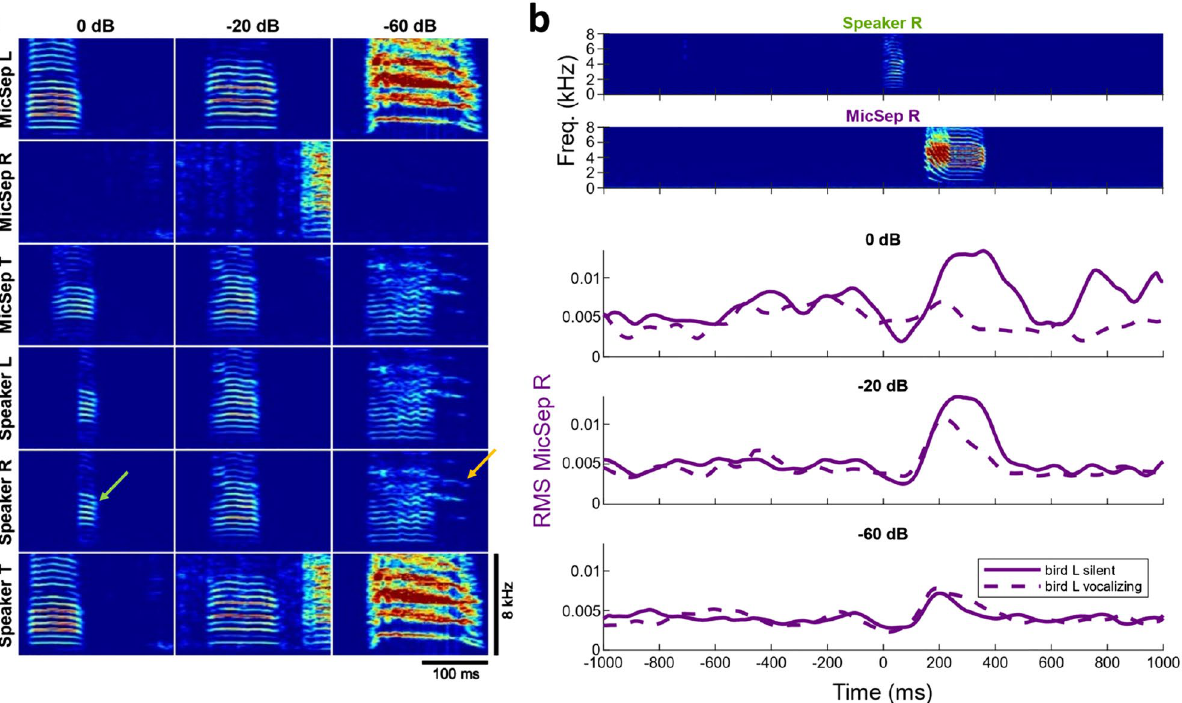
Figure 5. The leakage factor of the dynamic squelch sets the tradeoff between transmitting all local signals (i.e., soft calls) and suppressing leaked signals (i.e., loud residual echoes). ( a ) In a hierarchical network among 3 males, we set three different leakage factors, 0 dB (left), − 20 dB (middle), and − 60 dB (right). Shown are example spectrograms in which the top bird T produces a soft call (MicSep T) simultaneously with a loud call in L (MicSep L). A high dynamic squelch (left) produces a chopped version of T’s call on the Speaker R signal (green arrow). A midrange setting of the leakage factor (middle) preserves T’s call on Speaker R. Absence of dynamic squelching (right) produces a superposition of both calls on Speaker R, which entails that bird R can hear residual echoes of bird L (orange arrow). ( b ) Top: example spectrograms of a soft call in T (speaker R) and the response in R (MicSep R, purple) when L is silent. Bottom: root-mean square (RMS) of MicSep R signal averaged over instances in which T produces soft calls during silence (solid line) and instances in which T produces a soft call simultaneously with a loud call in L (as in a, dashed line). Time zero is the (visually detected) onset of the call in T. In case of a high leakage factor (0 dB, top), R fails to respond to concurrent calls in T (dashed line is flat). In the case of a midrange or low leakage factor setting (− 20 dB and − 60 dB), R responds similarly to both isolate and jamming calls (full and dashed lines are similar). Instances (7/540) in which T called into R’s response (in the interval [100,1000] ms) were excluded from the plot, although their inclusion had essentially no visual effect on the